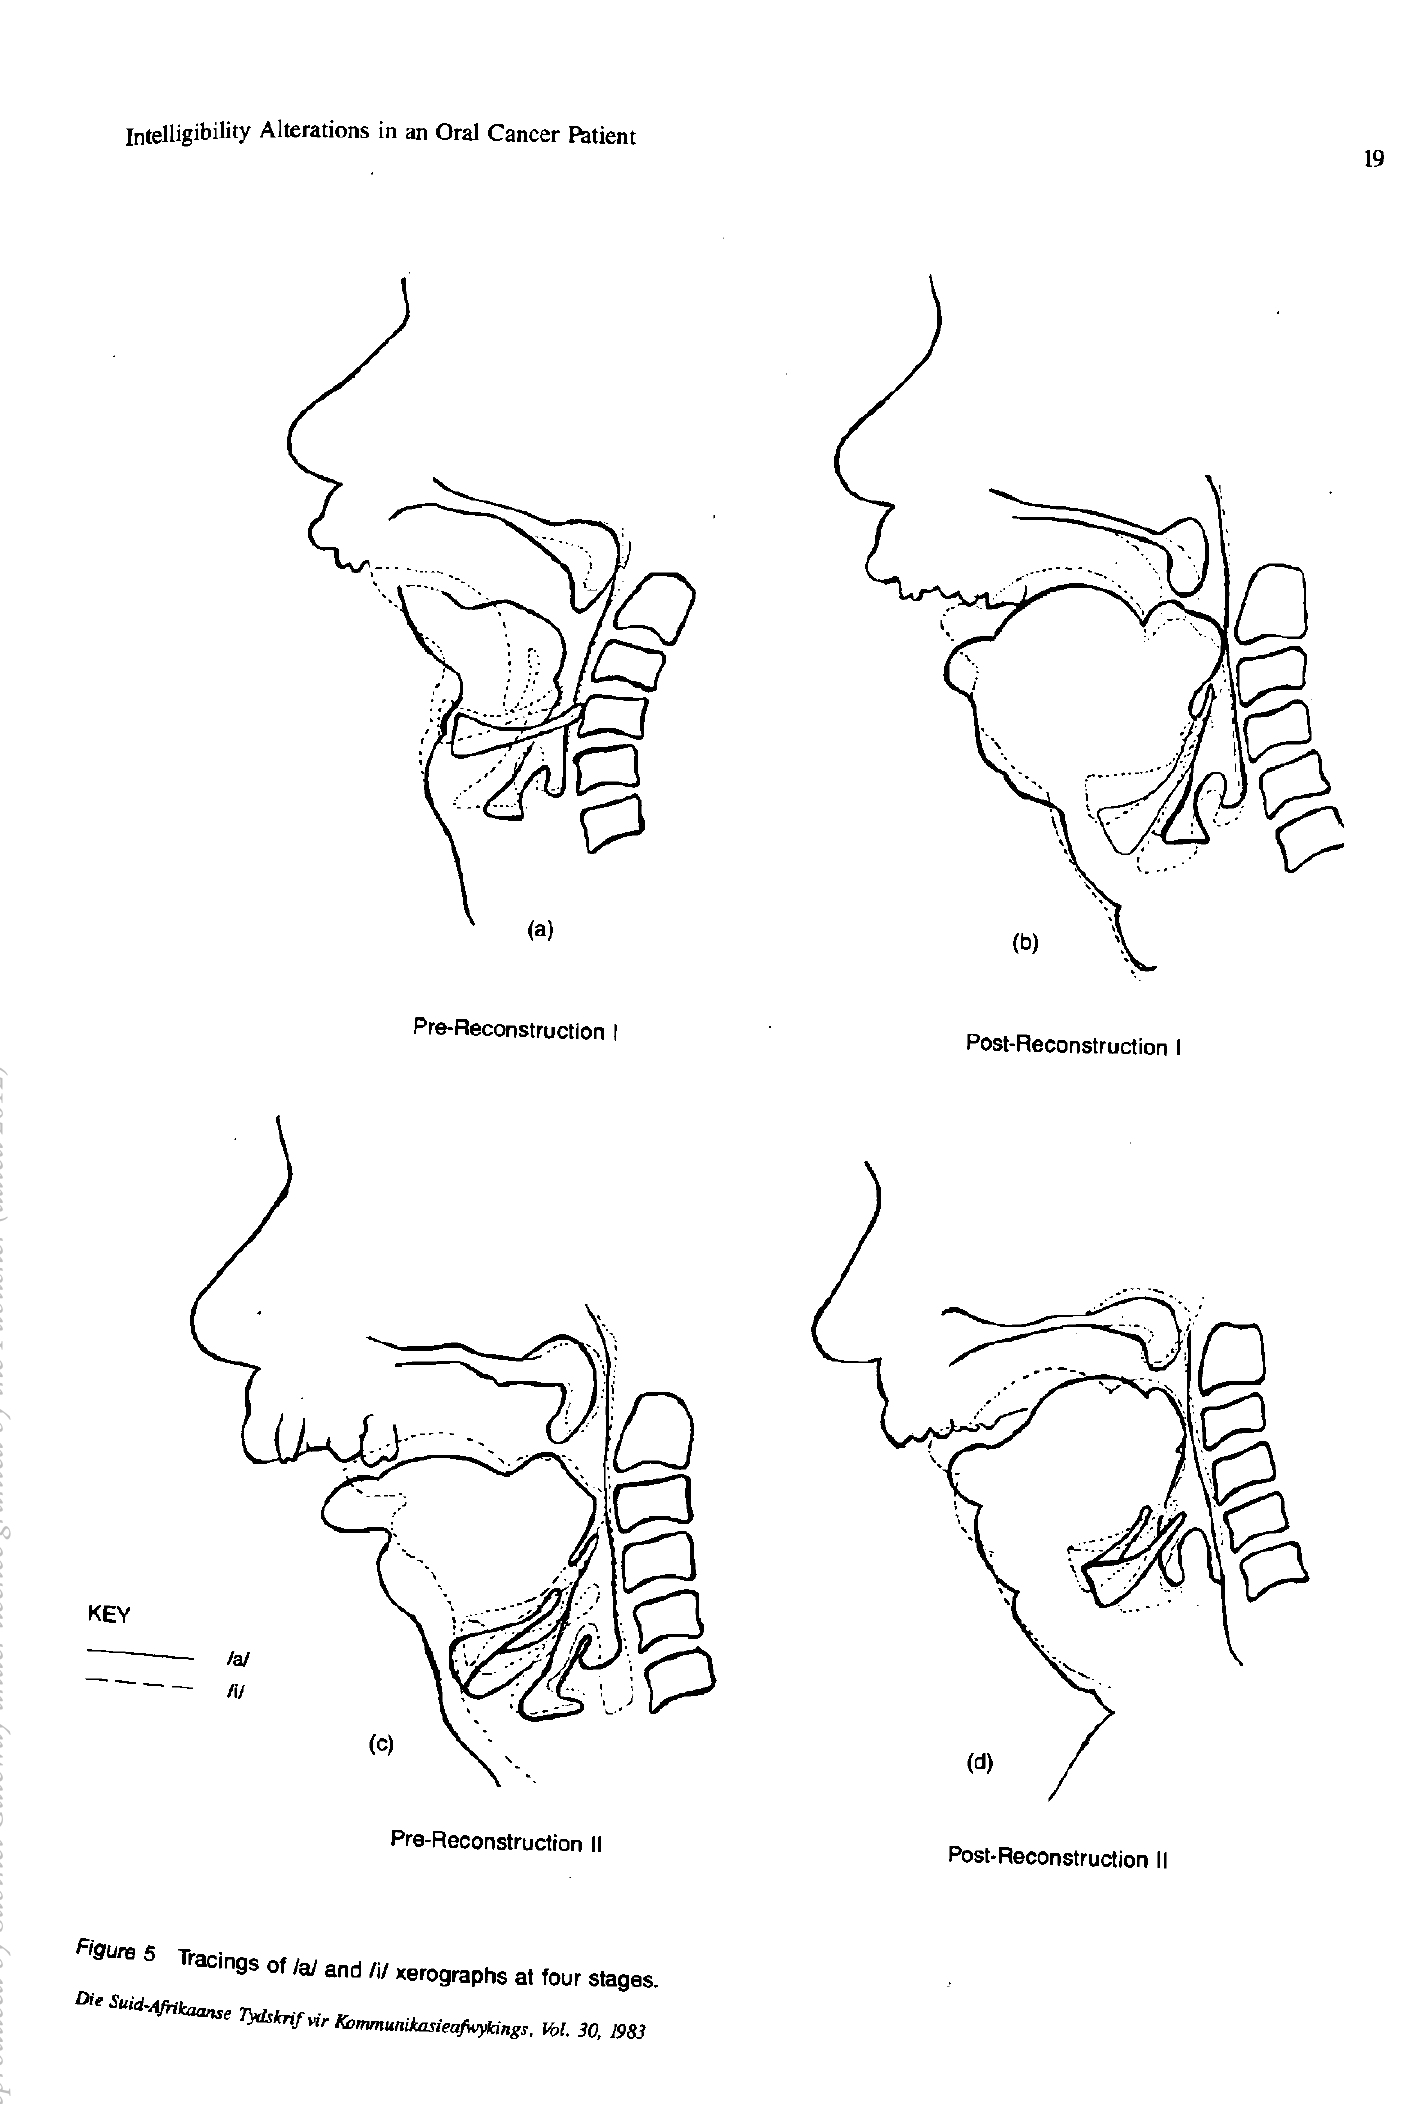
Figure 5 Tracings of /a/ and /i/ xerographs at four stages. Die Suid-Afrikaans 6 ^^fvir Kommunikasieafwykings, Vol. 30,